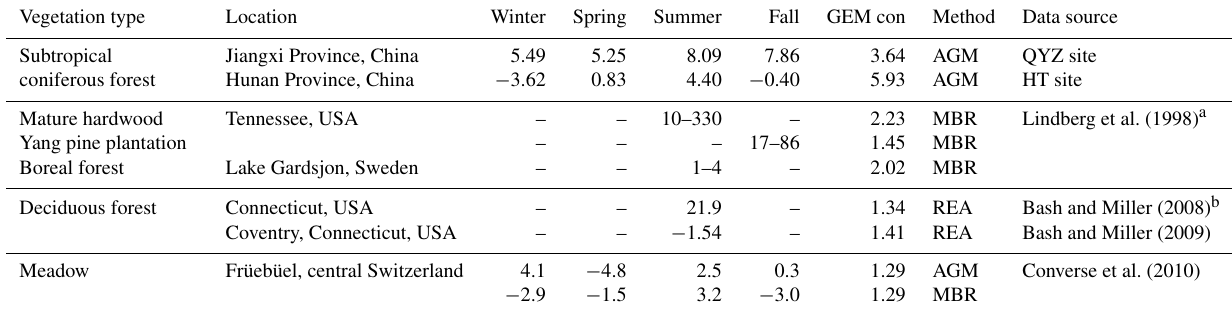
Table 3. Comparison of the GEM flux (ngm − 2 h − 1 ) from different observations. Vegetation type